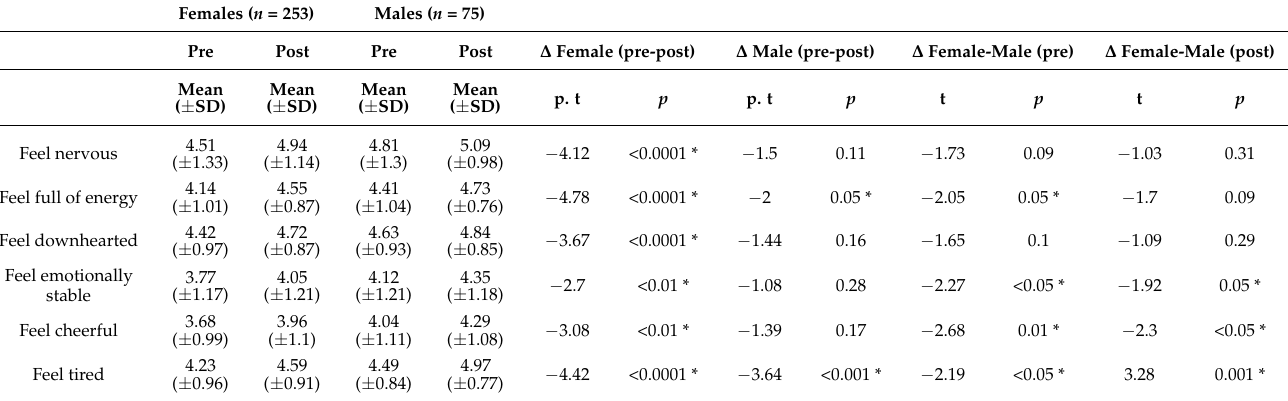
Table 3. Psychological differences within and between